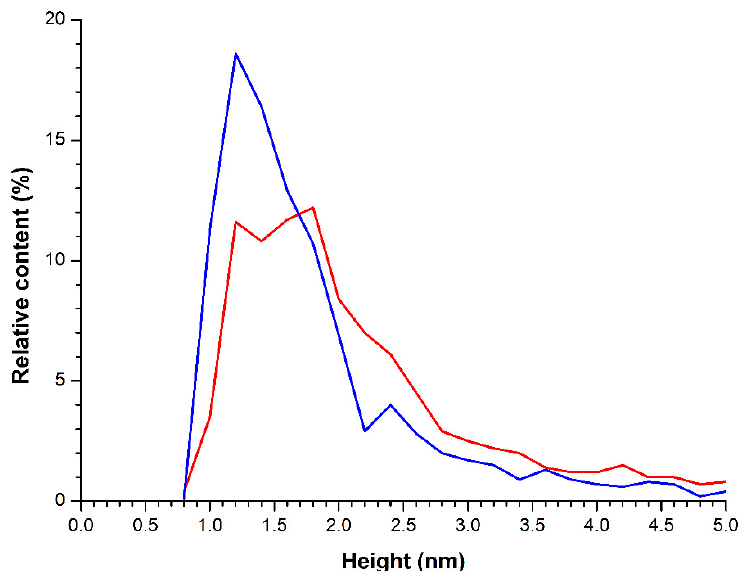
Figure 3. Results of processing of the AFM data obtained upon the analysis of HRP solutions. Typical plots of the relative distribution of the imaged objects with height ρ (h). The cell with HRP solution was placed either far away at a 10 m distance from the polymeric pipe coil (control experiment, blue line), or near the coil (red line).